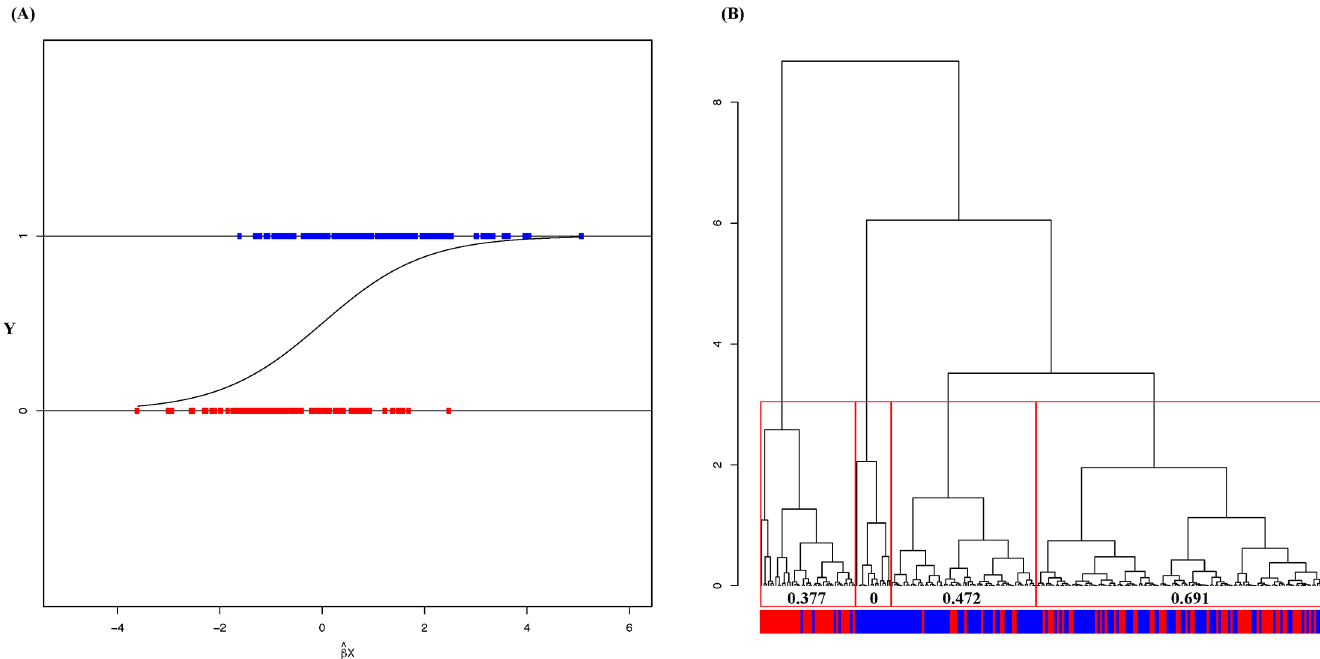
Fig 1. An expandable logistic regression setup and possibly heterogeneity. (A) Binary horizontal layout with respect to ^ b X calculated entropies for each cluster. A high degree of overlapping between the two horizontal layout in (A) indicates inefficiency of Logistic regression. In contrast, the heterogeneity within each gender categories in (B) gives rise to precise results in clusters of ^ b X